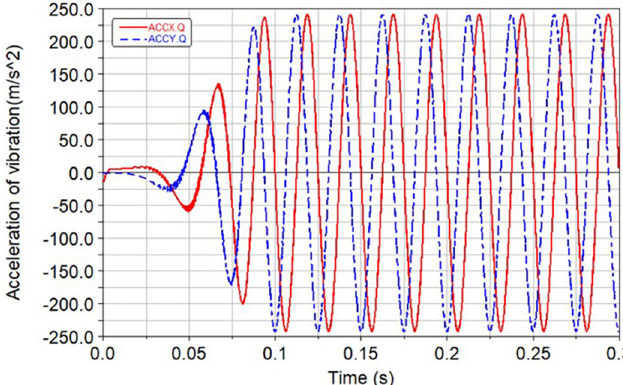
Fig 12. Vibration response during rigid gear transmission.